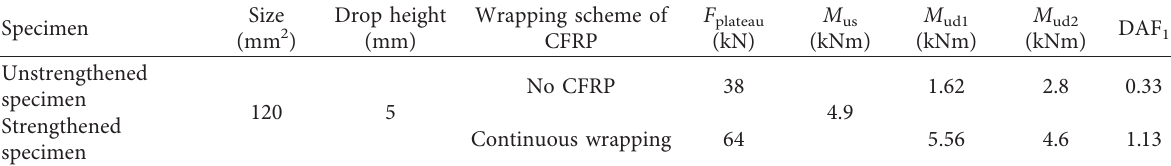
Table 2: Comparison of the tested specimens.